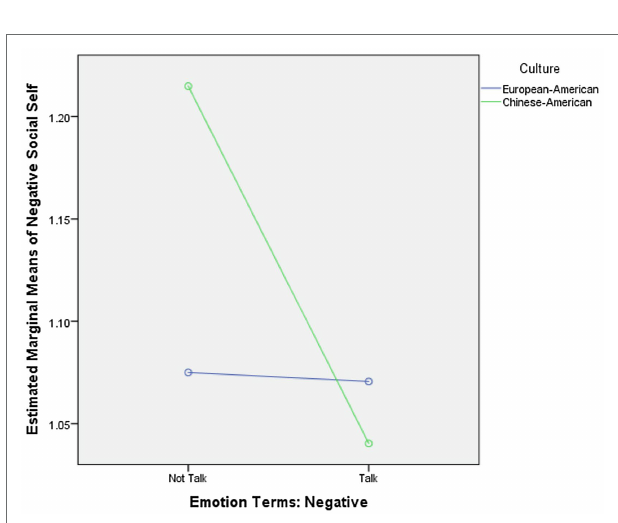
EA = European-American; CI = Chinese-American.